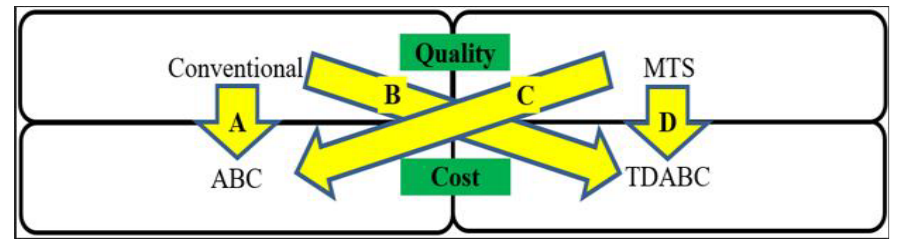
Figure 2. System integrations.